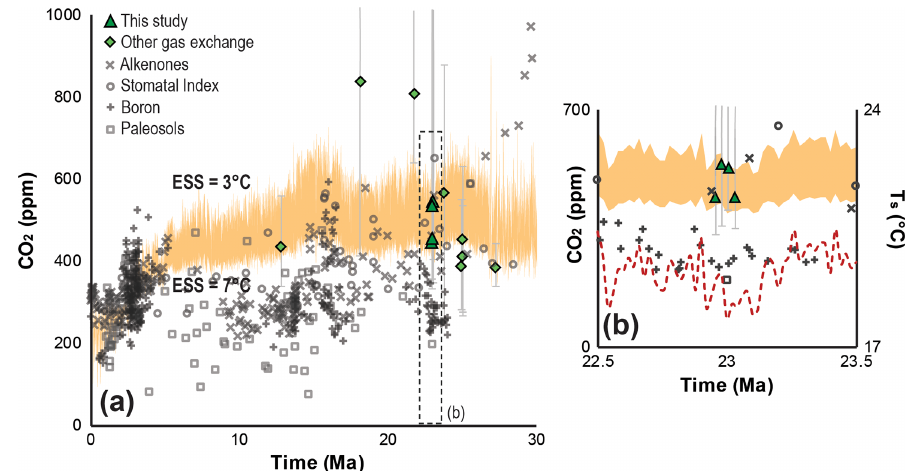
Figure 4. Neogene Earth system sensitivity (ESS) and C a reconstructions. Calculated C a levels for an ESS range of 3–7 ◦ C (orange shaded area) for the last 30Myr (a) and for the interval between 22.5 and 23.5Ma (b) ; the red dashed line in panel (b) indicates the global average surface temperature ( T s ) in the earliest Miocene (Hansen et al., 2013). The ESS envelope was determined using deep-sea δ 18 O of benthic foraminifera (Zachos et al., 2001) and the transform function approach from Hansen et al. (2013) (Supplement). Proxy-based Neogene C a reconstructions are derived from a previously published compilation (Foster et al., 2017) and are supplemented with more recently published data (Ji et al., 2018; Londoño et al., 2018; Super et al., 2018; Greenop et al., 2019; Moraweck et al., 2019; Steinthorsdottir et al., 2019). Error bars on gas-exchange-based proxy estimates represent ± 1 σ